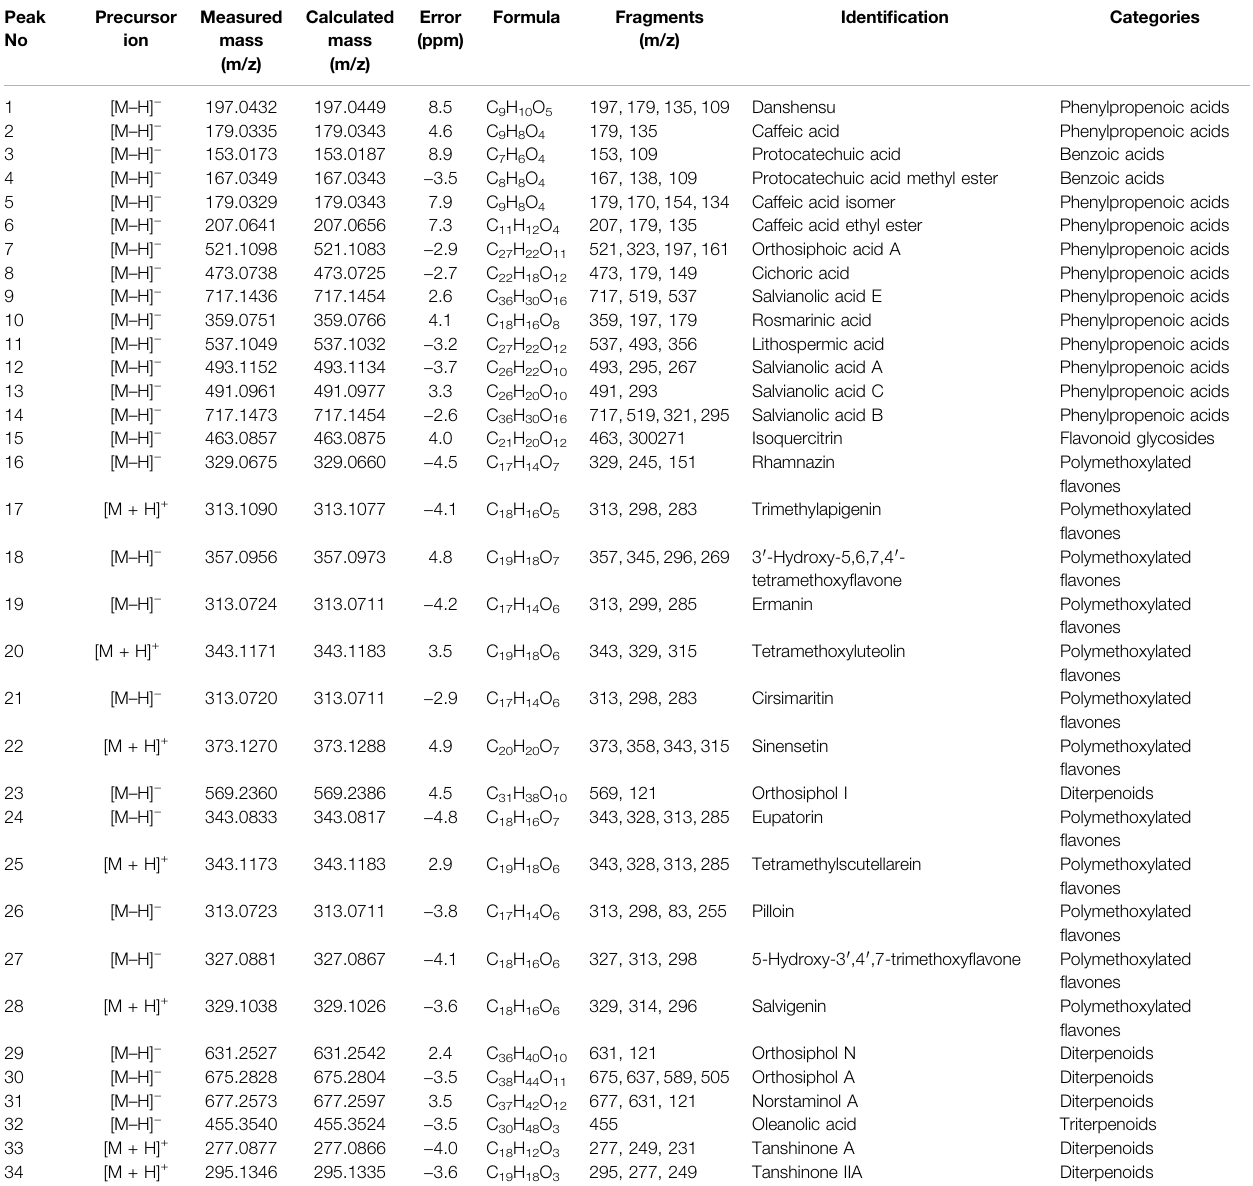
TABLE 1 | Constituents identi fi ed in the extract of Orthosiphon stamineus Benth. Peak Precursor No